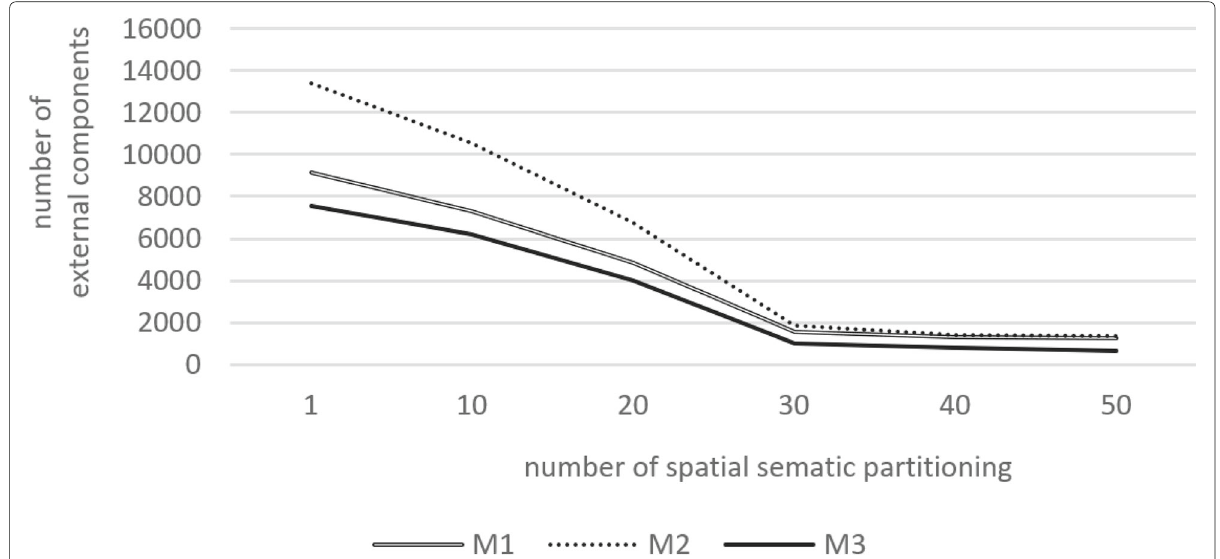
Fig. 11 Results of extracting external